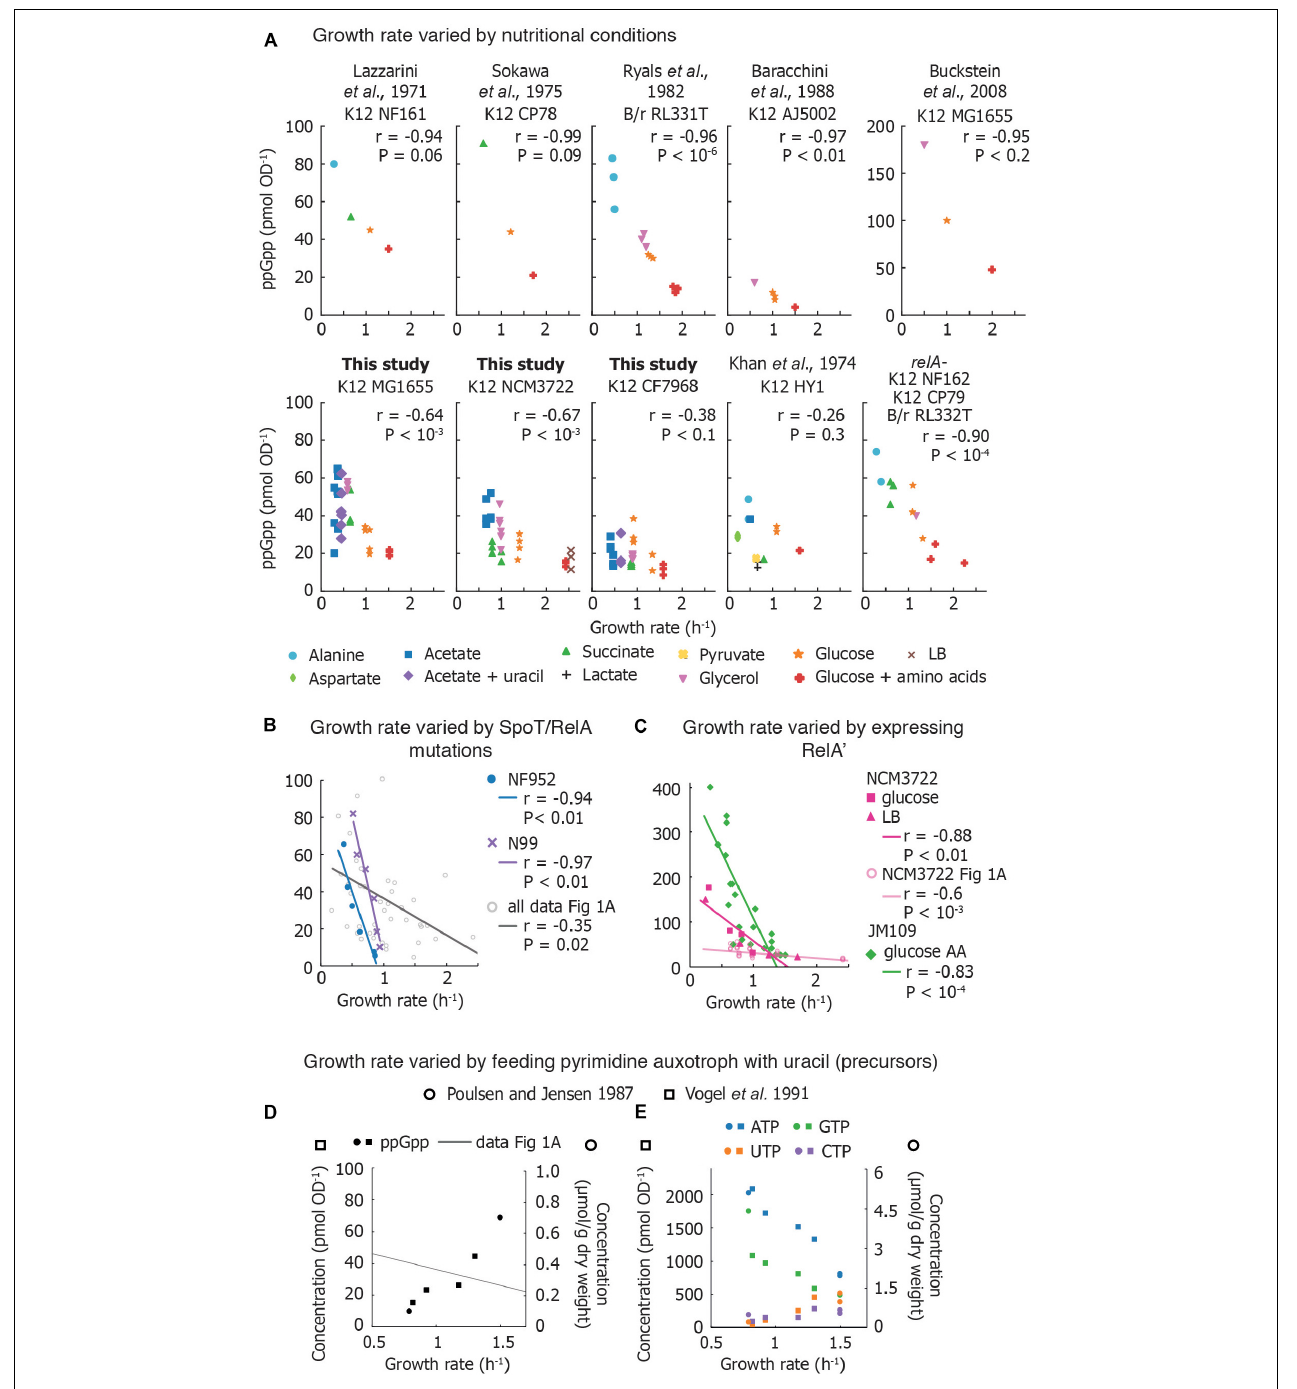
FIGURE 1 | Compilation of measurements of basal ppGpp vs. growth rate. (A) Basal ppGpp concentrations measured in E. coli strains that generally follow an inverse correlation with growth rate. Both literature data and data obtained for this study are shown ( Supplementary Section 3 ). For data from this study, three technical replicates per biological replicate are shown. For data taken from the literature, the number of biological replicates varies and can be found in Supplementary Material . (B) Trends obtained by several E. coli strains bearing various mutations in ppGpp synthase/hydrolase enzyme SpoT grown in glucose minimal medium. Each point represents values obtained from one strain. This is compared to compiled data from A. The genotype of each strain used can be found in Supplementary Material . (C) Basal ppGpp measured during overexpression of RelA in E. coli JM109 (in glucose amino acids without Gln, Glu) and in E. coli NCM3722 in LB and glucose minimal medium. (D,E) Ribonucleotide concentrations in E. coli strains defective in pyrimidine synthesis. (D) ppGpp concentrations as a function of growth rate, overlaid with the compiled ppGpp vs. growth rate data of (A) , and (E) intracellular ATP, GTP, UTP, and CTP concentrations. References to data sets are provided in the Supplementary Material . For (A–D) , the Pearson correlation coefficient r and significance figure P (from a two-tailed significance test) is shown.